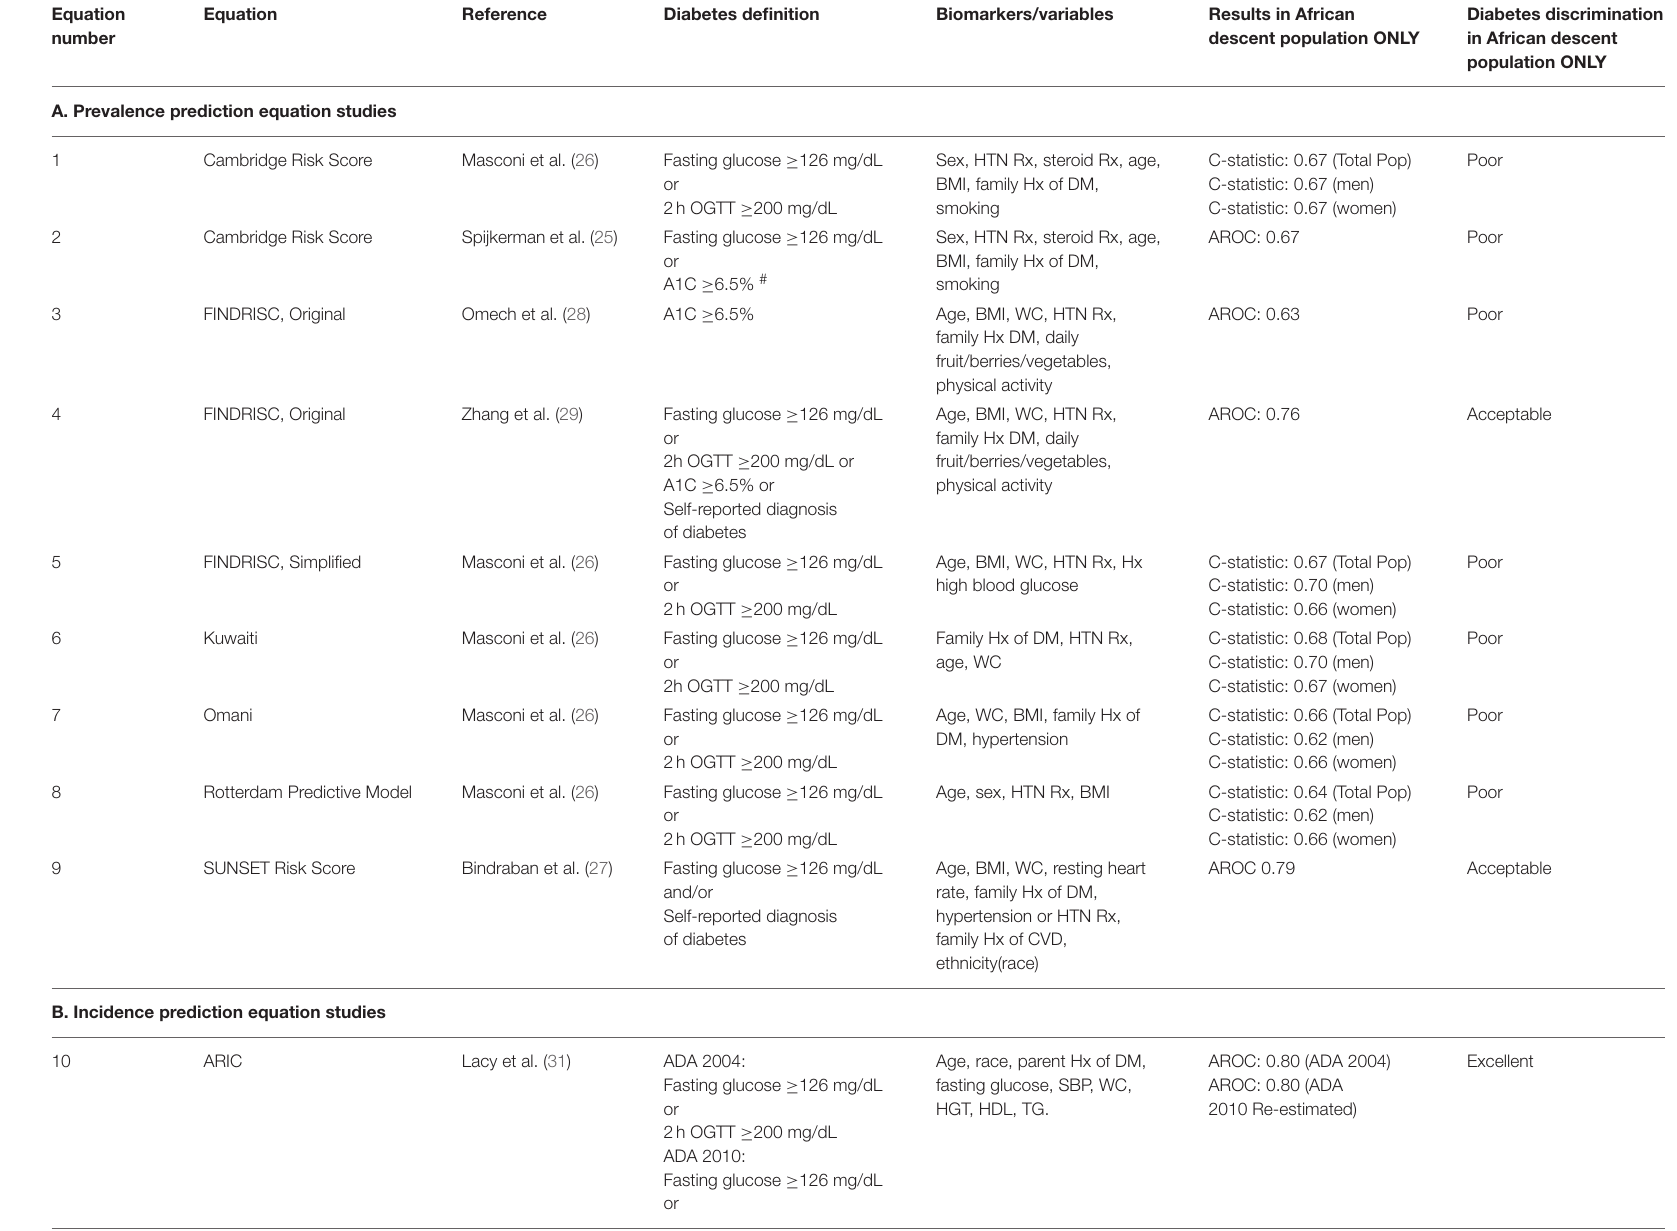
TABLE 3 | Diabetes prediction equation studies: variables, results, and main